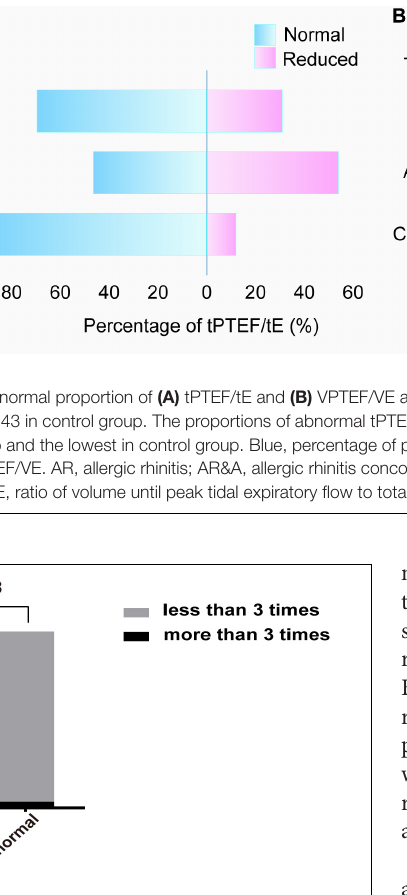
FIGURE 3 | Comparison of proportion of recurrent wheezing in reduced group and normal group of AR patients. The percentage of recurrent wheezing in reduced group was significantly higher than that in normal group ( P = 0.008). Reduced, patients with reduced pulmonary function in AR group; normal, patients with normal pulmonary function in AR